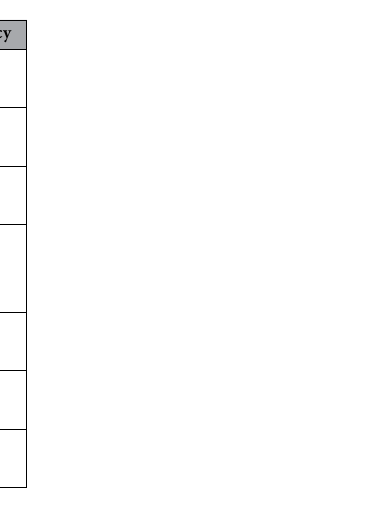
Table 6. The optimized parameter